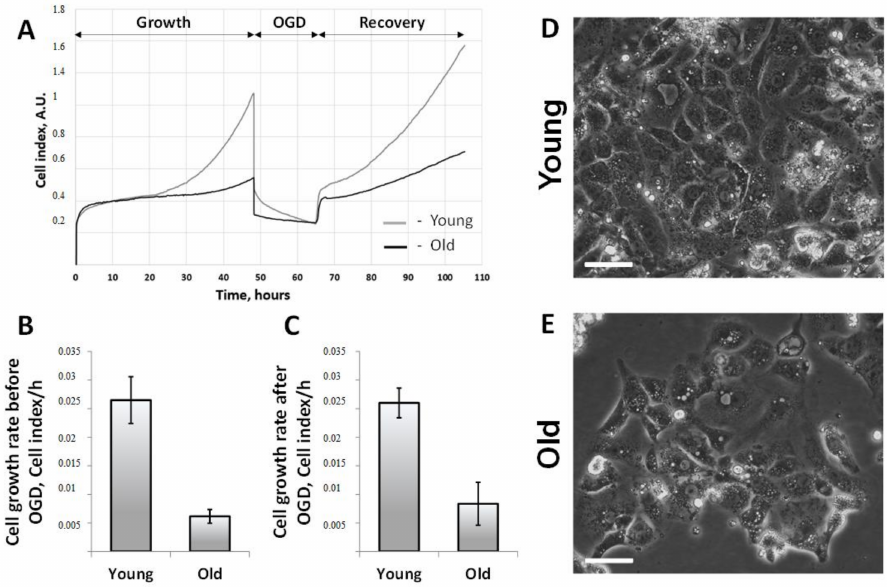
Figure 5. The proliferation of primary cultures of RTCs obtained from kidneys of young and old rats, and the rate of recovery after oxygen-glucose deprivation (OGD). ( A ) Kinetics of proliferation of primary cultures of RTCs evaluated by iCelligence, including growth under normoxic conditions, death during OGD, and the recovery of RTCs after the restoration of oxygen supply and complete culture medium; ( B ) Growth rate of RTCs under standard conditions; ( C ) Growth rate after OGD; ( D , E ) Phase-contrast microscopy images of the primary cultures of RTCs obtained from kidneys of young and old rats. The scale bar indicates 100 µ m. * p < 0.05 compared to young